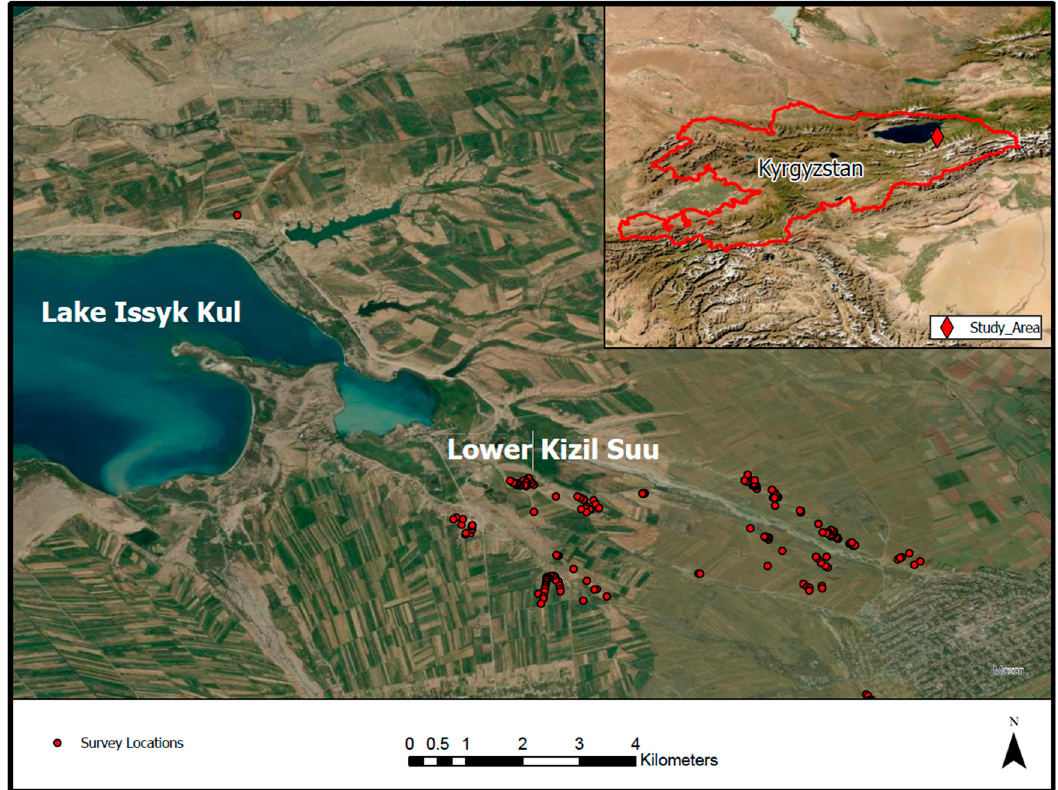
Figure 1. Locator Map of Study Area of Kizil Suu region.